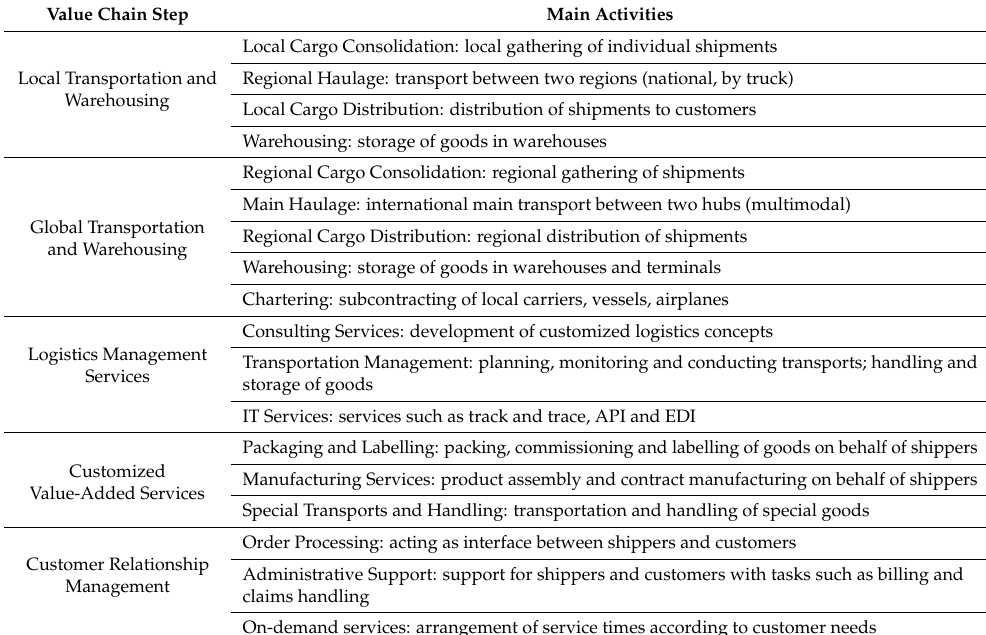
Figure 3. Activities of generic 3PL business models along the logistics service value chain. Dark grey fields indicate main activities, light grey fields indicate supplementary activities and white fields indicate that the value chain step is not covered by the respective business model. Table 1. 3PL value chain activities.